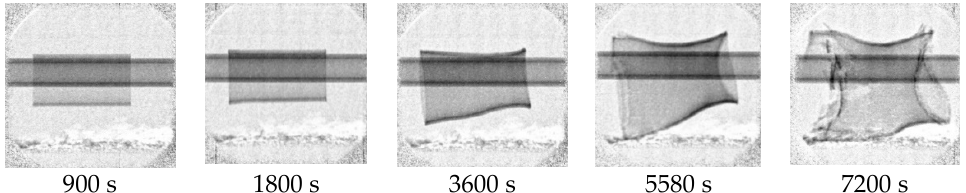
Figure 11. Radiographs of the sample reacted in a nitrogen/steam atmosphere with a total gas flow rate of 24 L/h.